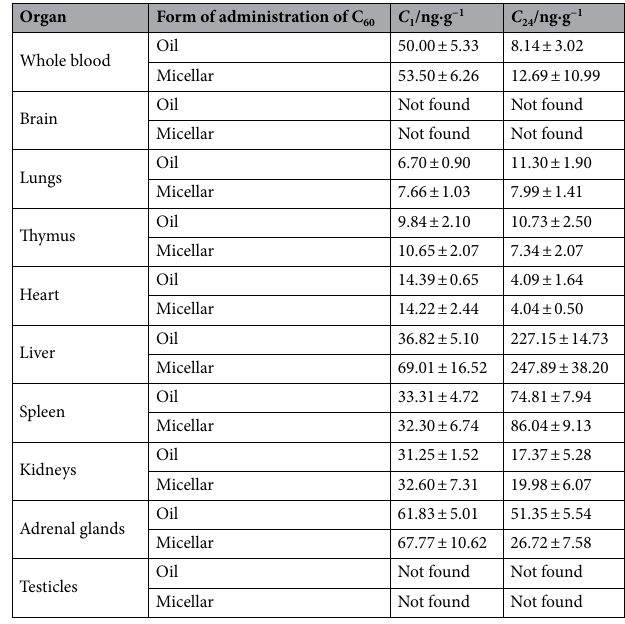
Table 5. Fullerene content in various organs after administration of an oil dispersion of fullerene to mice after 1 h ( C 1 ) and 24 h ( C 24 ) (data are given as mean ± standard deviation of the